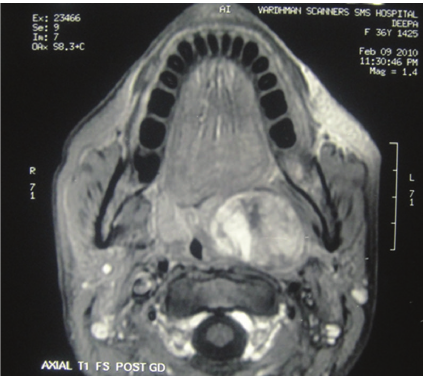
Figure 3: T1-weighted post-Gd MRI image showing preservation of a fat plane between the tumor and parotid gland.